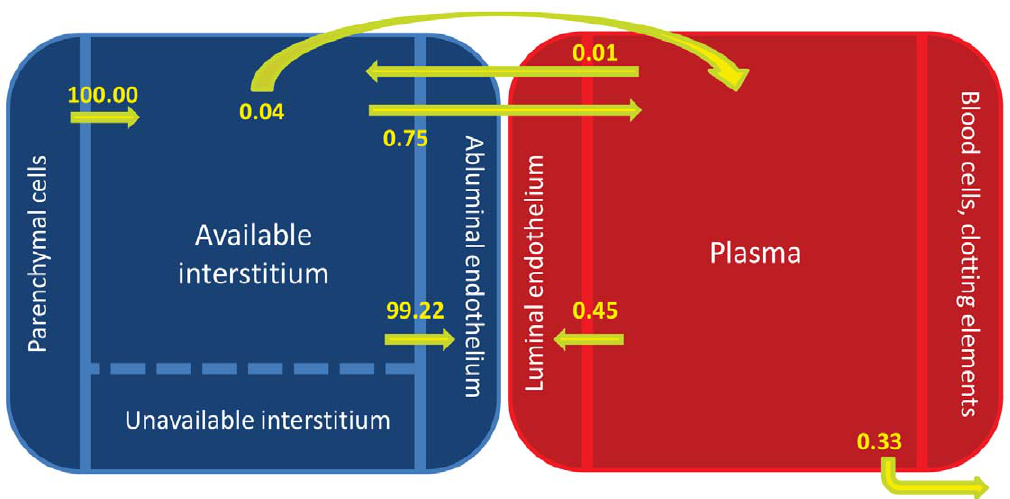
Figure 6. Normalized flows at steady-state. Flows of VEGF are normalized to that of the secretion flow. Most of the VEGF/receptor complexes are removed from the tissue through internalization. As with Figure 1, internalization in the tissue compartment includes both that of VEGF/receptor complexes on the abluminal surfaces of endothelial cells as well as VEGF bound to NRP-1 on myocyte cell surfaces. There is a net flow of VEGF from the tissue into the blood compartment via microvascular